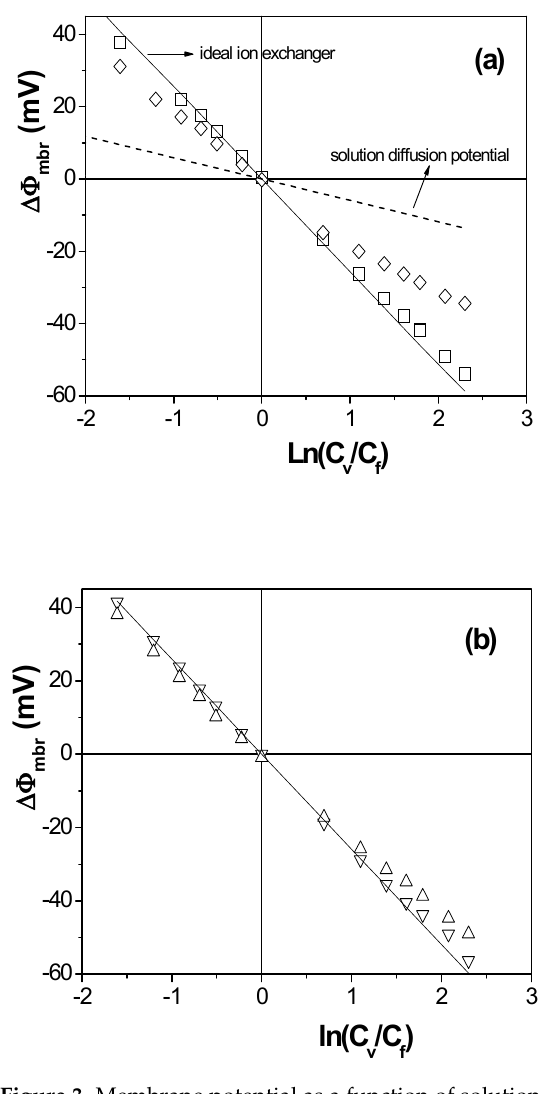
Figure 3. Membrane potential as a function of solution ratio for: ( a ) Sf-NPAM/TiO 2 membrane ( □ ), Ox-NPAM/TiO 2 membrane ( ◊ ) solution diffusion potential (dashed line) for NaCl electrolyte, and (solid line) ideal positively charged membrane (t − = 1); ( b ) Sf-NPAM/TiO 2 membrane and KCl solutions ( Δ ), CaCl 2 solutions ( ▽ )